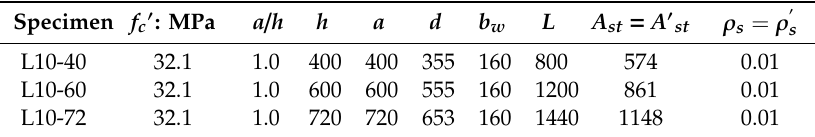
Table 1. Test specimen specifics (Yang et al.